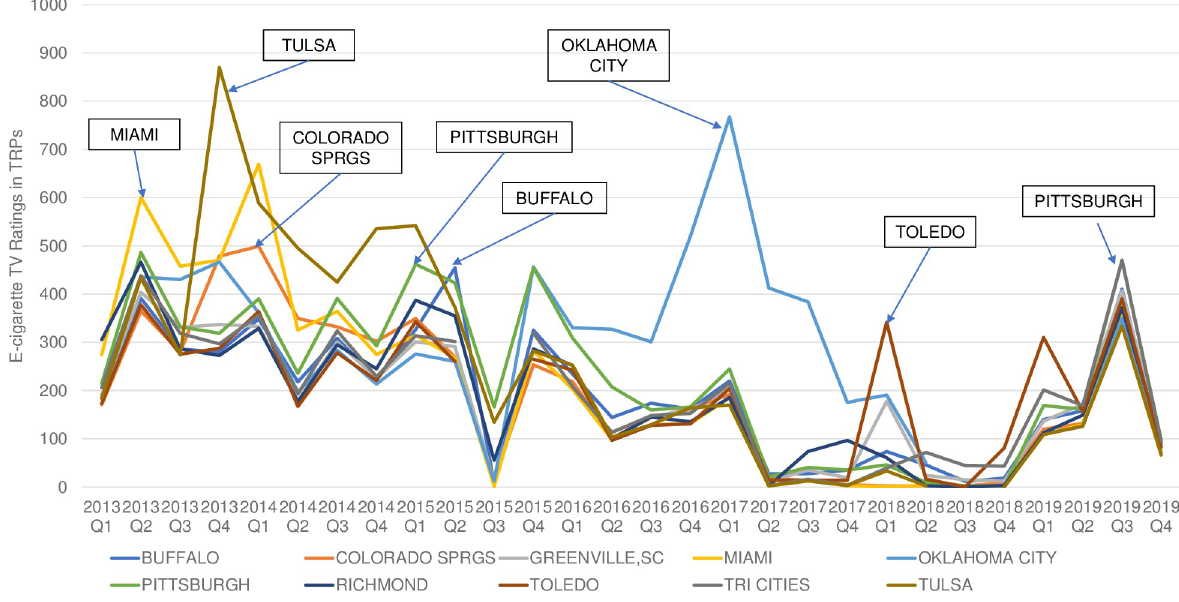
Fig 2. Youth (age 12–17) quarterly e-cigarette TV target rating points (TRPs) by top 10 Nielsen retail market, 2013–2019.